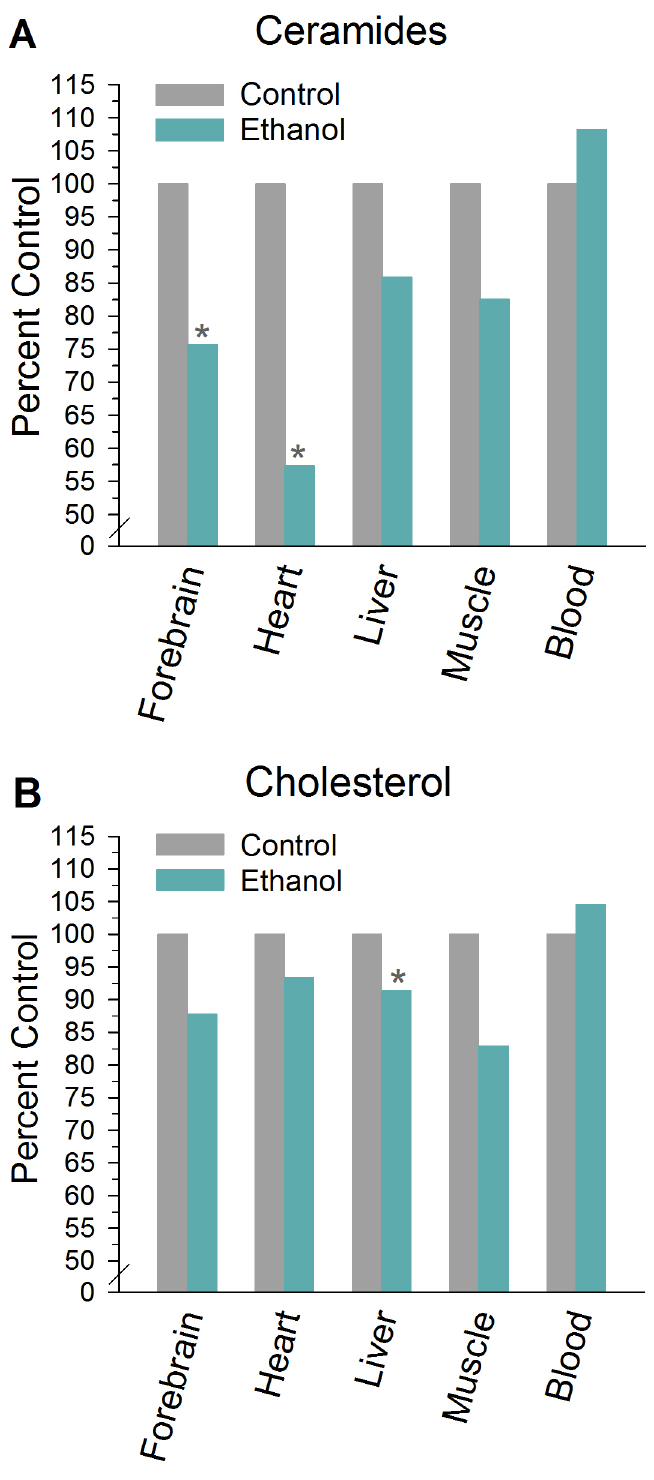
Fig 2. Levels of ceramides (A) and cholesterol (B) for each tissue type (represented as percent control) in selectively bred alcohol-preferring (P) rats exposed for 13 weeks to a 20% ethanol intermittent access drinking paradigm or given access to water alone (non-exposed control). Percent control = ((mean optical density value for ethanol/mean optical density value for control) × 100). * Significant difference between ethanol and control within tissue type ( P <